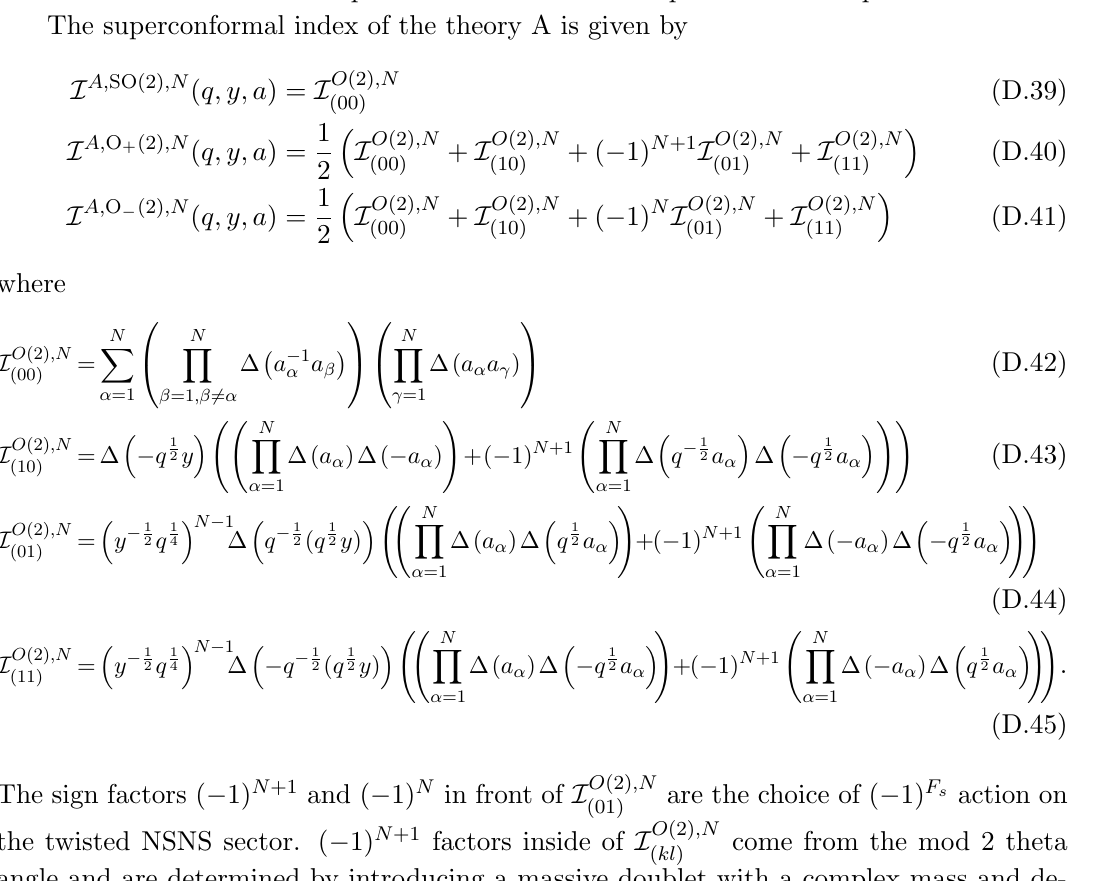
come from the mod 2